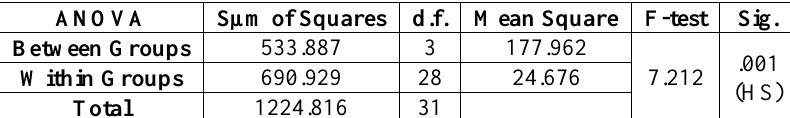
Table 2: One way-ANOVA test among the four groups